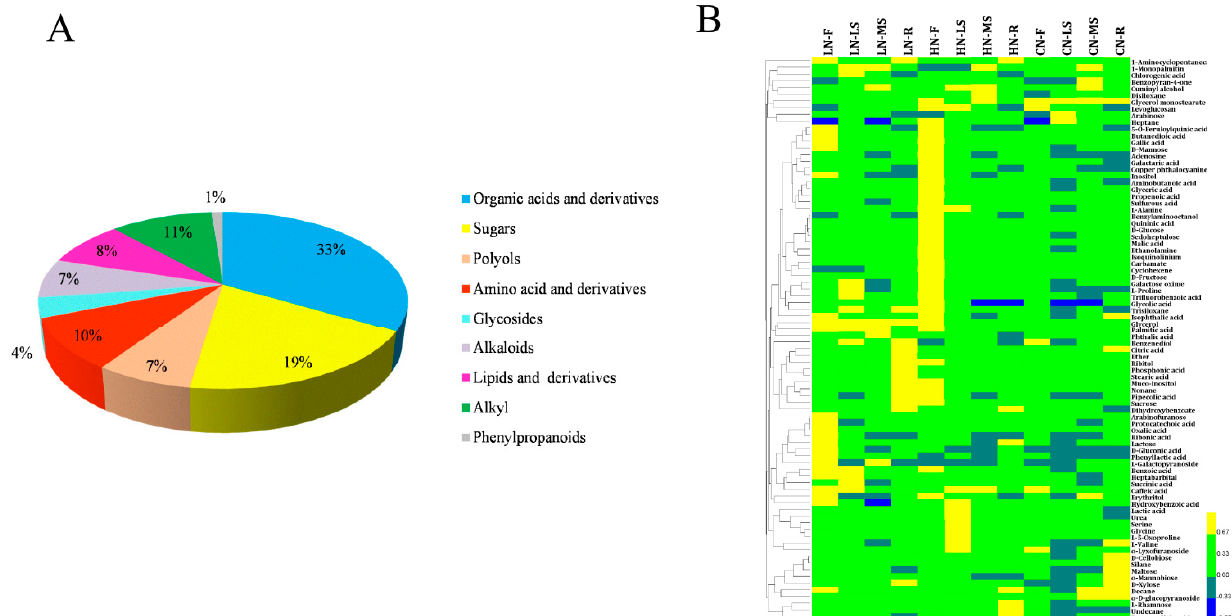
Figure 3. ( A ) Classification of 84 metabolites based on Bupleurum . ( B ) The cluster analysis and heat map for 84 metabolites under different levels of nitrogen fertilization and in different plant parts. CN: control nitrogen; LN: low nitrogen; HN: high nitrogen; R: root; MS: main shoots; LS: lateral shoots; F: flower. The up − regulated and down − regulated metabolites are represented as yellow and blue, respectively. The green color means that abundance is 0, as shown in the upper right-hand bar.